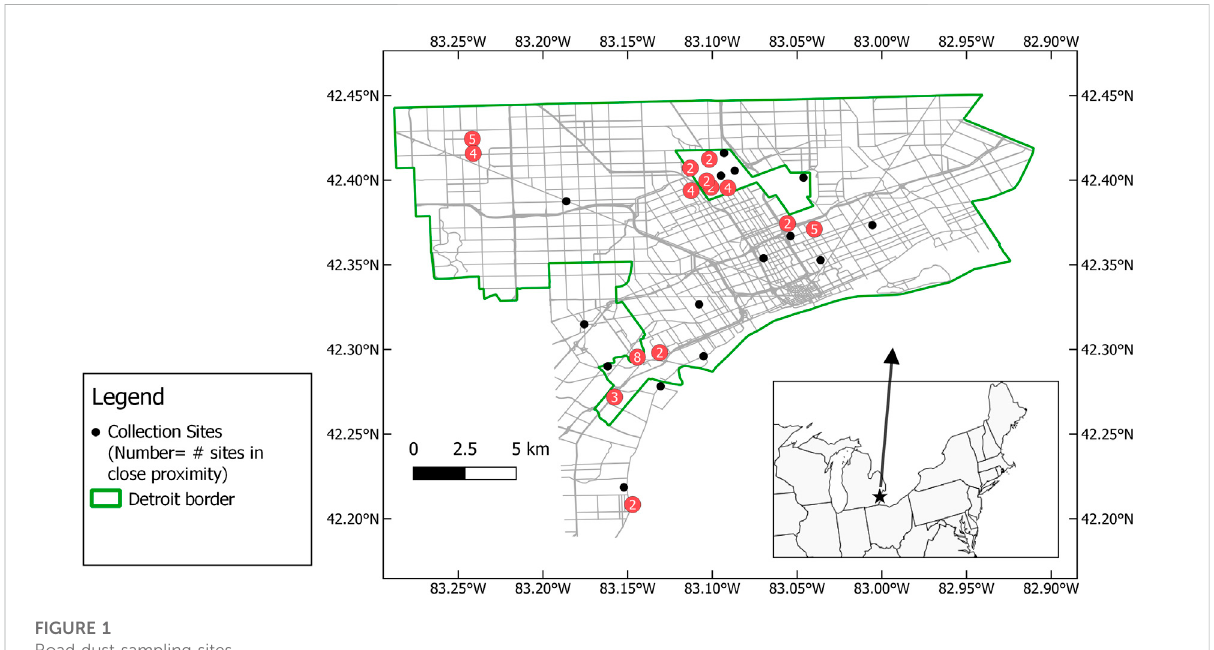
FIGURE 1 Road dust sampling